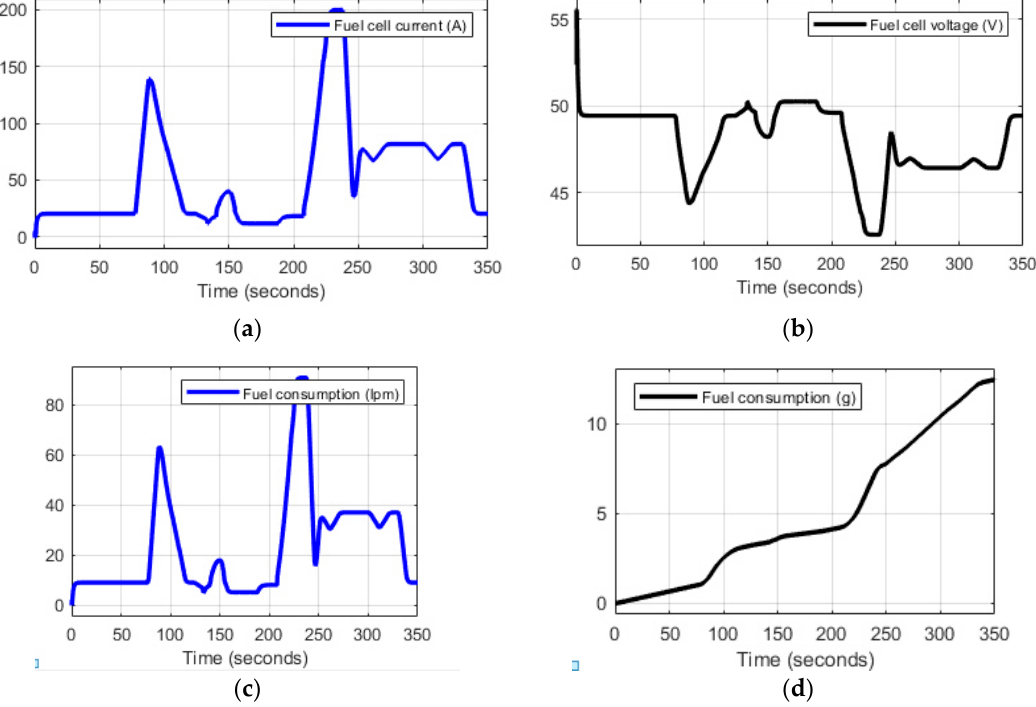
Figure 19. ( a ) Fuel cell current, ( b ) fuel cell voltage, ( c ) fuel cell rate, ( d ) fuel consumption.